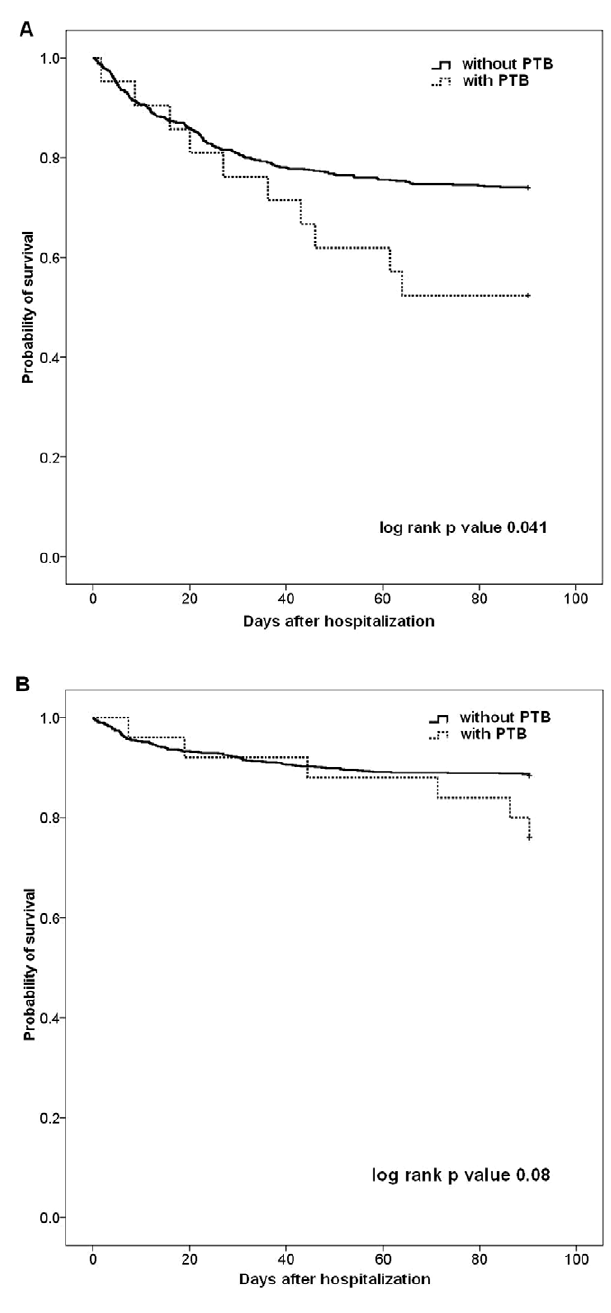
Figure 2. Kaplan-Meier survival curves of hospitalized pneu- monia patients with or without concomitant PTB. Patients with (A) HCAP and (B) CAP were stratified by the presence or absence of concomitant PTB within 60 days. HCAP, healthcare-associated pneu- monia; CAP, community acquired pneumonia; PTB, pulmonary tuber- culosis.